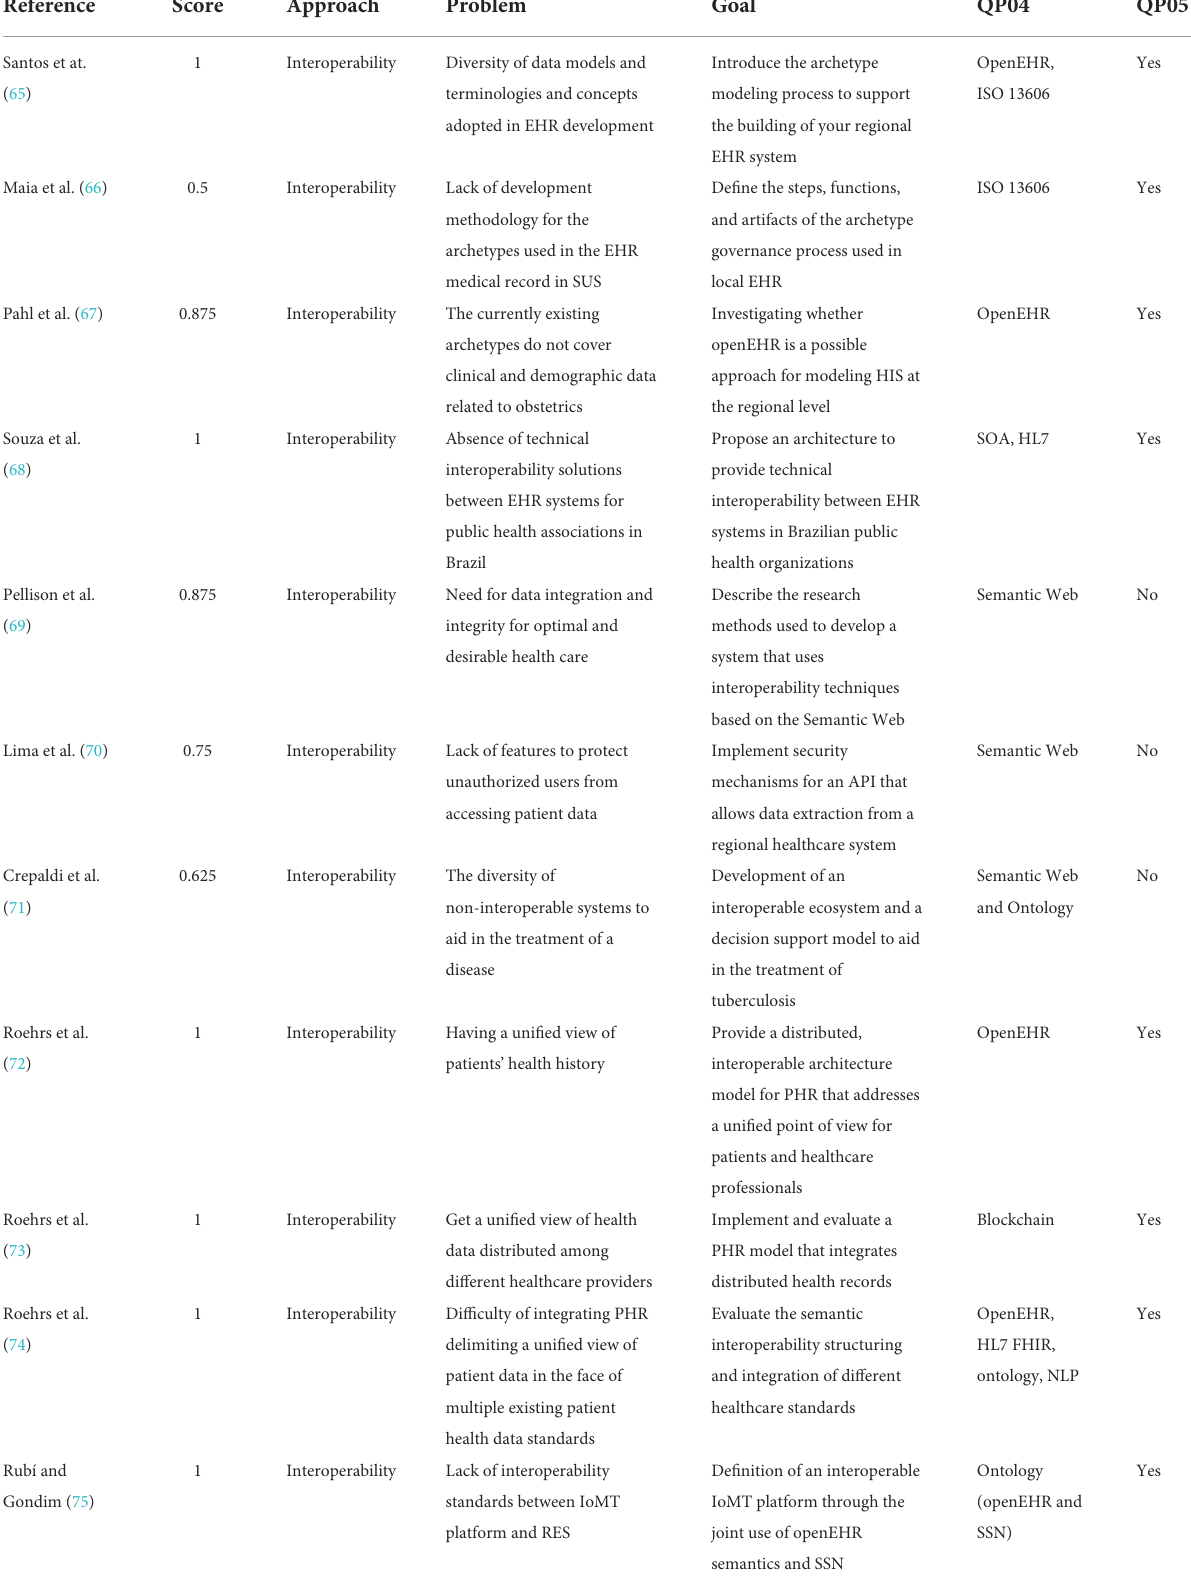
TABLE 5 Characteristics of the selected set of